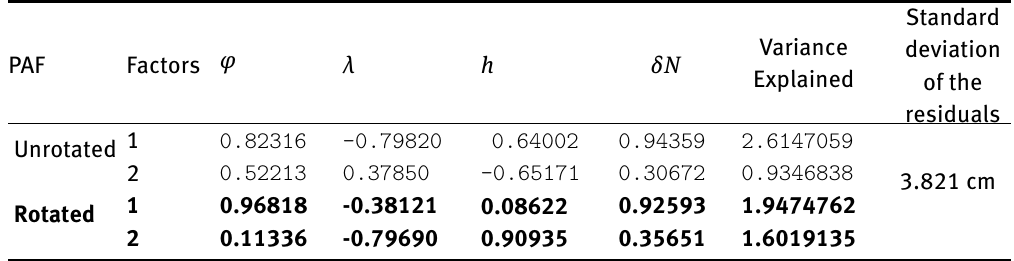
Table 3: The unrotated and rotated loading coefficients of the PAF results from the 2-factor case.